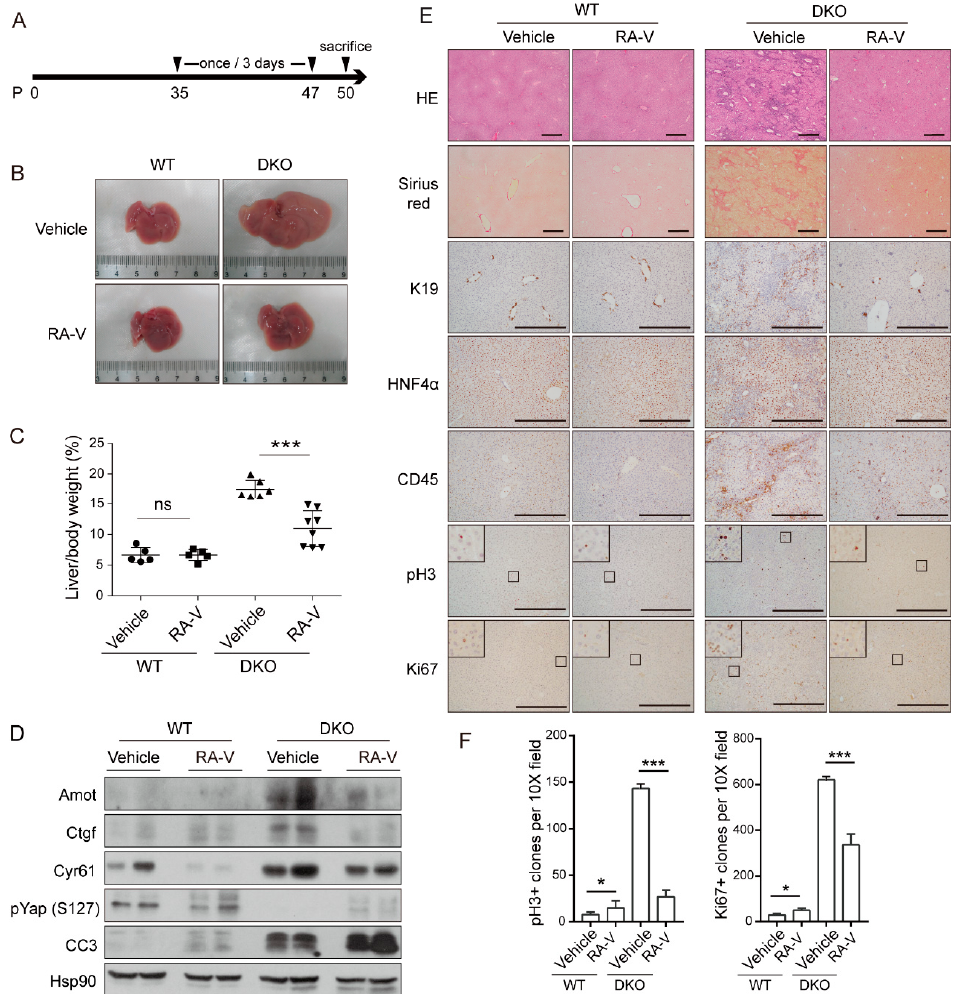
Figure 3. RA-V inhibits liver enlargement induced by Hippo pathway inactivation. ( A ) Schedule of vehicle or RA-V (10 mg/kg) injection. P: postnatal day. ( B ) RA-V inhibits liver enlargement in Mst1/2 double knockout (DKO) mice. Images are representative of at least 5 mice. ( C ) Statistical analysis of the data in (B). Values represent mean ± SD with all data points plotted. ( D ) RA-V represses the protein levels of YAP target genes and induces apoptosis in liver. Liver tissue samples from two mice in each group were analyzed by western blotting. ( E ) Pathological and immunohistochemical (IHC) staining of liver sections from (B). Results are representative of at least five mice. Scale bars, 500 μ m. Squared regions were enlarged for detailed view. ( F ) Quantification of pH3 (left panel) and Ki67 (right panel) positive cells. Six representative views were quantified. Experiments were duplicated. p values were determined by Student’s t test. ns, not significant; *, p < 0.1; ***, p <